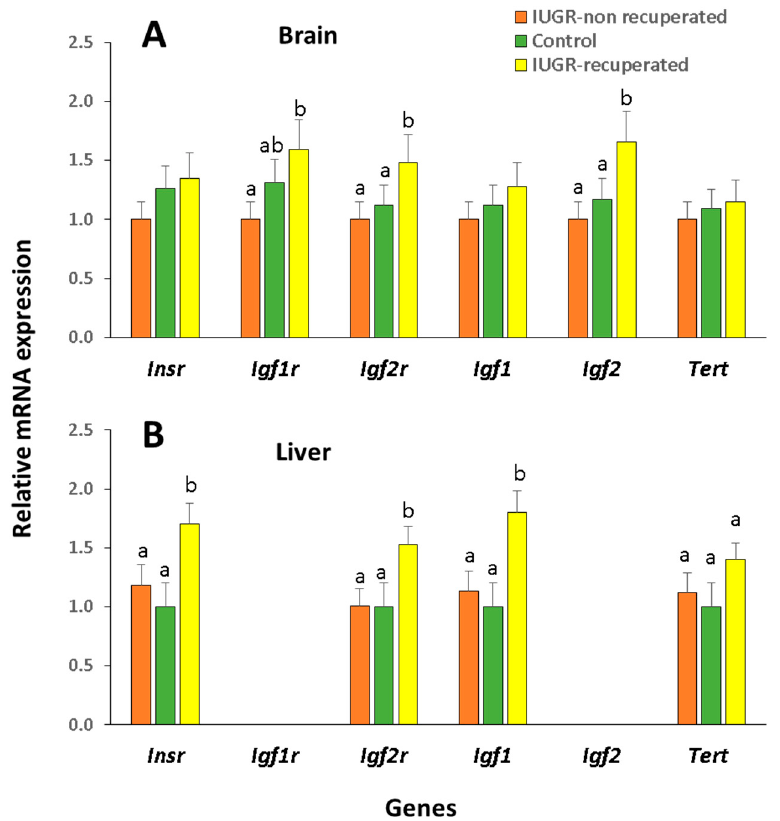
Figure 4. Relative mRNA expression of insulin receptor and insulin-like growth factors and receptors in IUGR B6 female animals. Relative expression levels recorded at 3 months of age in the IUGR-non recuperated, control, and IUGR-recuperated groups in brain ( A ) and liver ( B ). Data expressed relative to levels recorded in the housekeeping genes Actb and H2afz . Results are provided as the mean ± SD. a,b different letters indicate significant differences between groups ( p < 0.05).